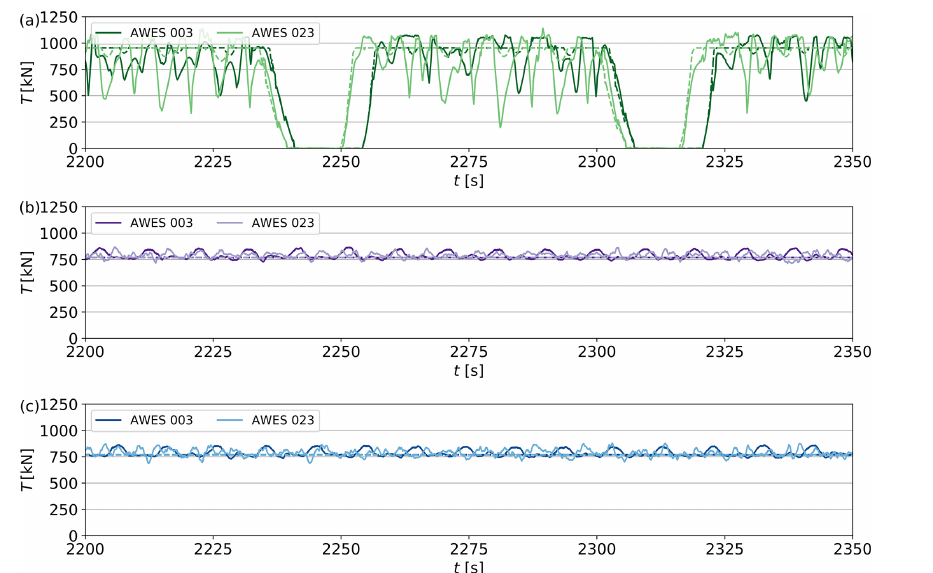
Figure 18. Time series of tether tension T T monitored by the front and rear AWE systems of the central park column ( x = 2000m) for the AWE parks L1 (a) , D1 (b) , and D2 (c) . The coloured dashed lines show the reference quantities of the tracked trajectories.